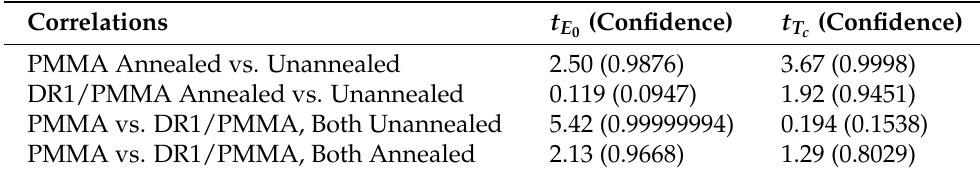
Table 3. T -test results (and confidence levels) for E 0 and T c from Table